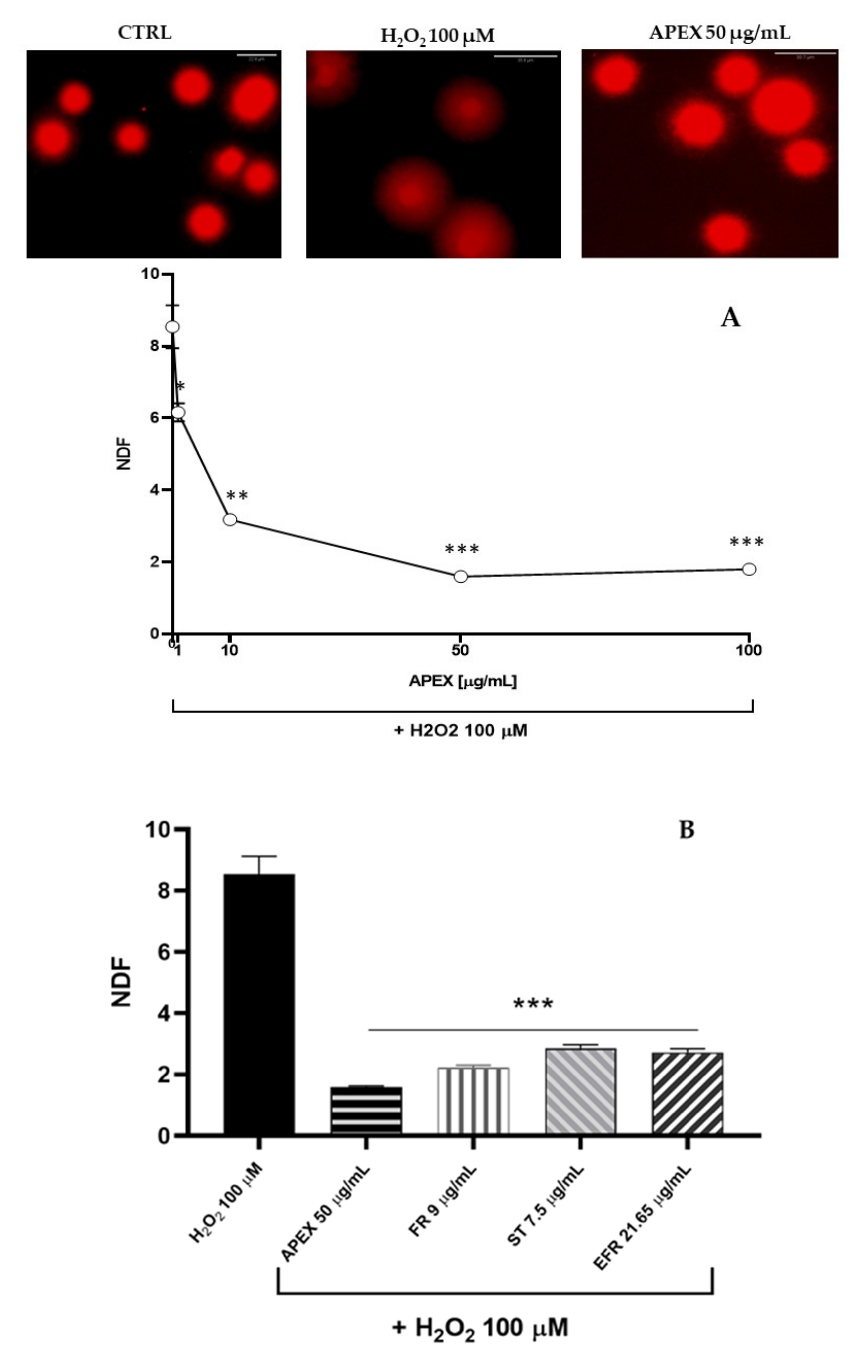
Figure 5. Effect of APEX and its major components on oxidant-induced DNA breaks. ( A ) Representative micrographs of U937 cells exposed to H 2 O 2 preincubated for 24 h in the absence or presence of increasing concentrations of APEX; ( B ) extent of DNA lesions in the nuclear DNA from cells preincubated for 24 with APEX, FR, ST or EFR prior to oxidative challenge. Values are expressed as NDF and are the means ± SEM of three independent experiments. * p < 0.05, ** p < 0.001 and *** p < 0.0001 vs. H 2 O 2 .